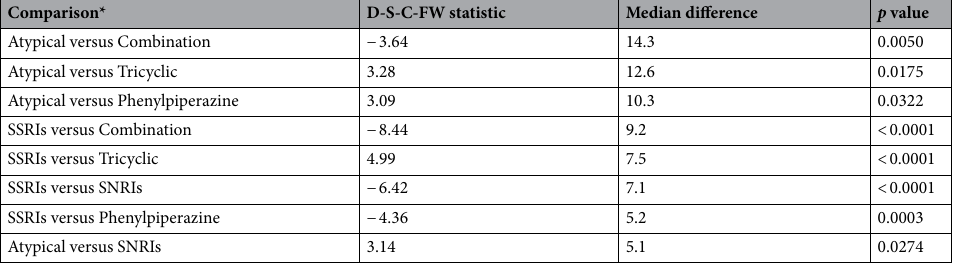
Table 5. Pairwise comparisons of antidepressant treatments on physical HRQoL using Dwass–Steel– Critchlow–Fligner statistics. *Only significantly different results are listed. SSRIs: Selective serotonin reuptake inhibitors; SNRIs: Serotonin and norepinephrine reuptake inhibitors; Combination: Patients using multiple